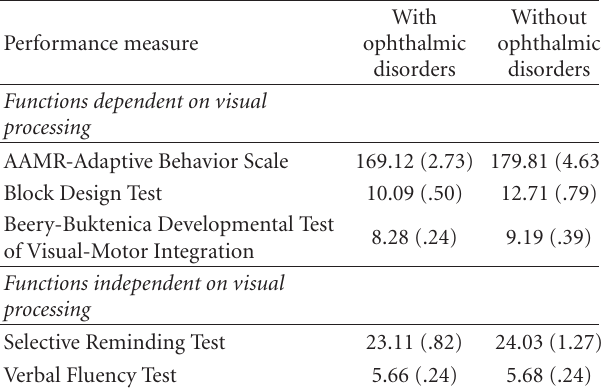
Table 4: Adjusted least square means and standard errors for adap- tive behavior and cognitive measures as a function of ophthalmic